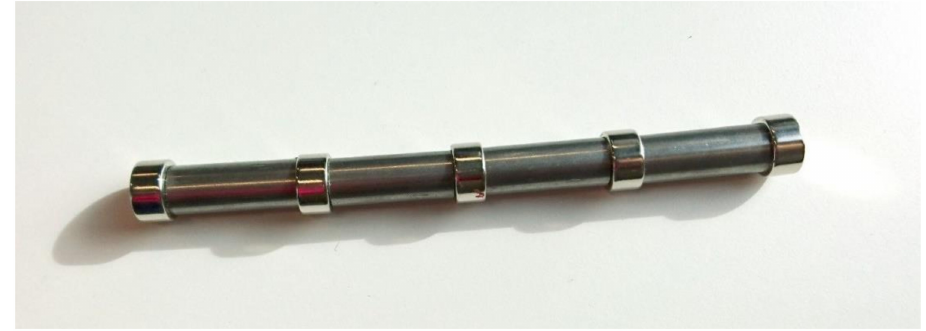
Figure 1. Photograph of the bar magnet that was built from five smaller disc magnets and separated by steel